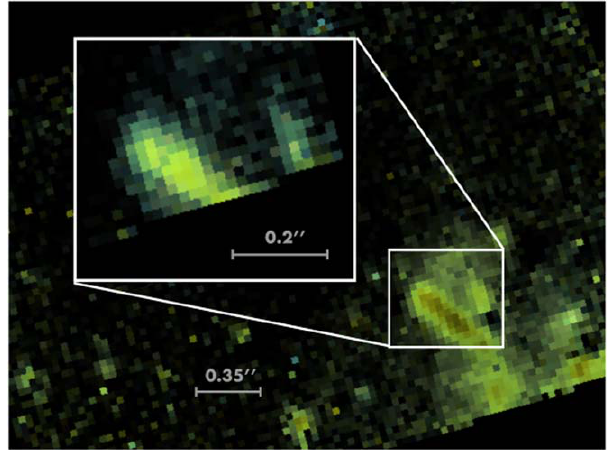
Figure 6. Zoom-in of the structure of X7 showing evidence for its fragmentation. The fi gure shows maps of Br- γ emission in 2020 using 35 and 20 mas ( inset at left ) pixel scales, obtained by integrating over velocities in the data cubes at which X7 ʼ s blueshifted Br- γ emission is present ( corresponding to wavelengths of 2.1612 – 2.1628 μ m ) . The line maps are cut out from the data cube at velocities around that of X7. In the 20 mas map, X7 is partially cropped, owing to the smaller fi eld of